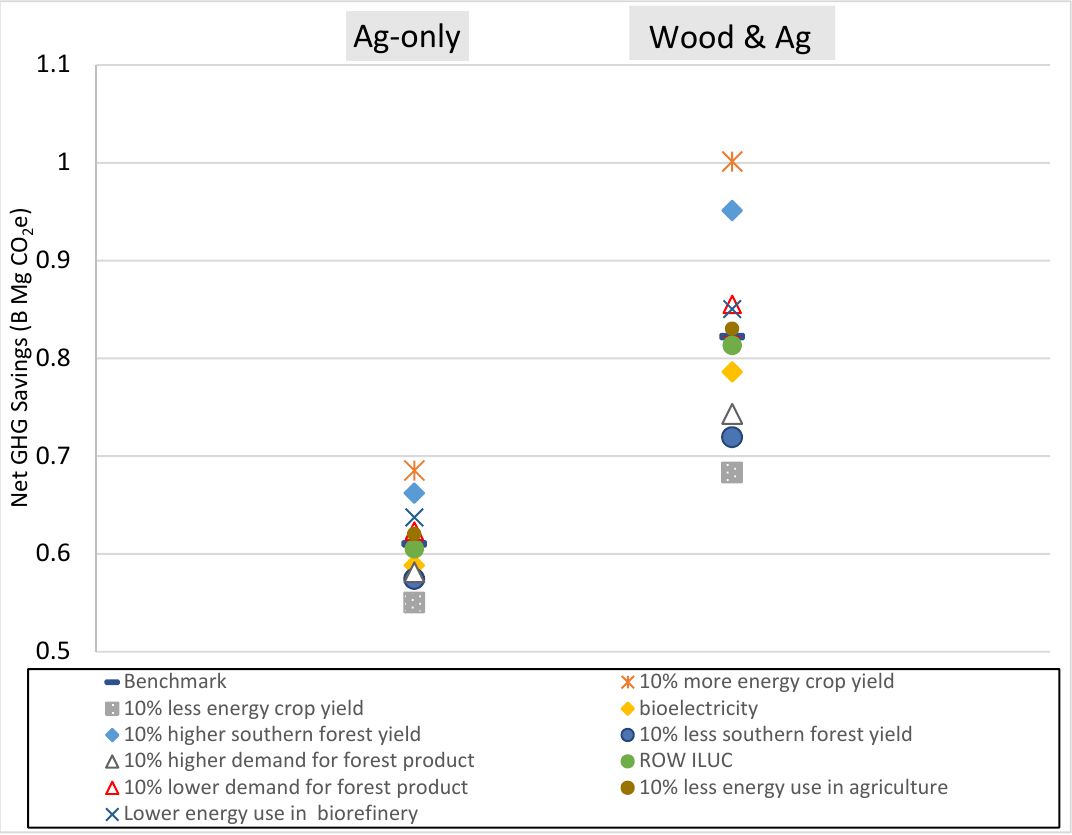
Figure 4. Sensitivity analysis of the cumulative GHG savings from displacing gasoline (2015–2035).